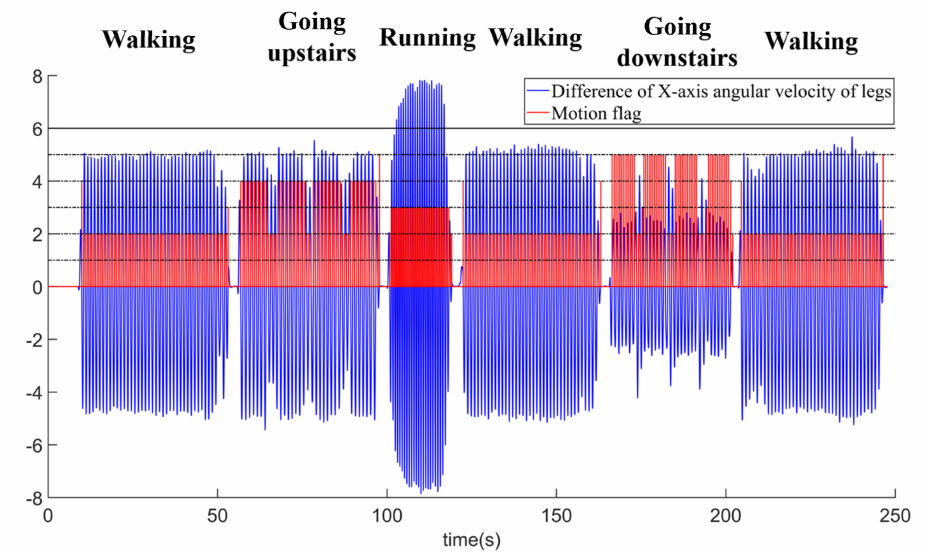
Figure 15. Recognition of multi-motion modes with LSTM for